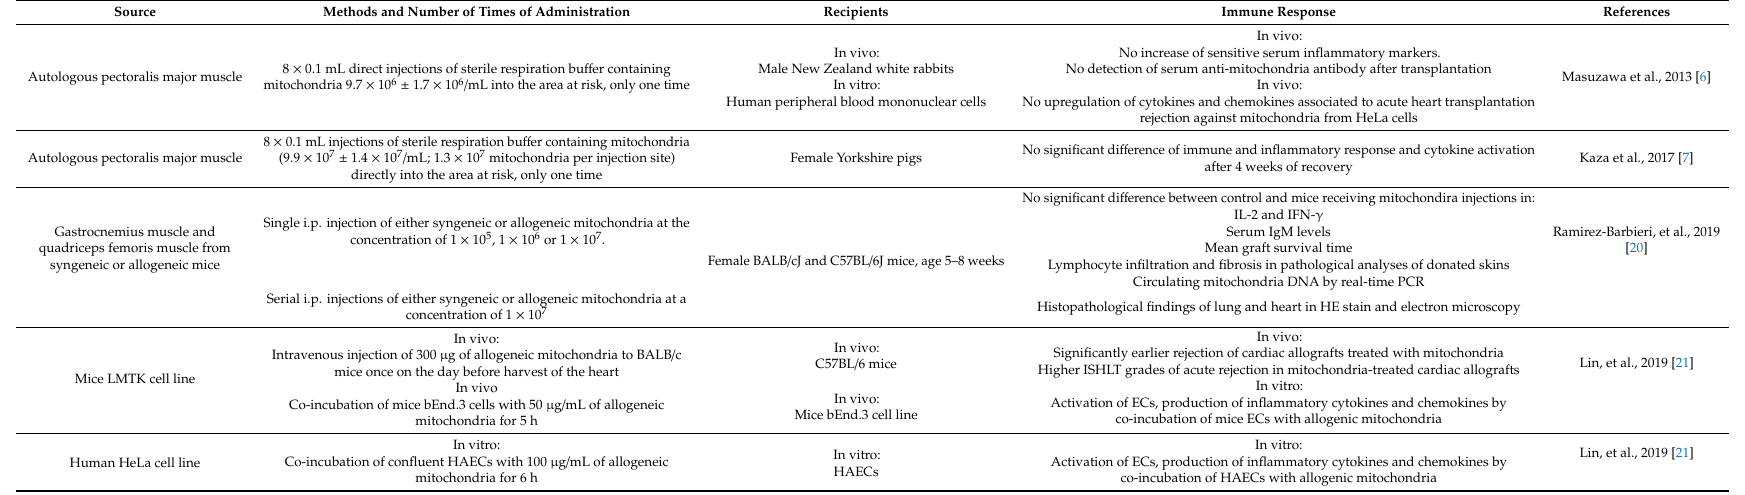
Table 4. Research reports of the immune response to mitochondrial